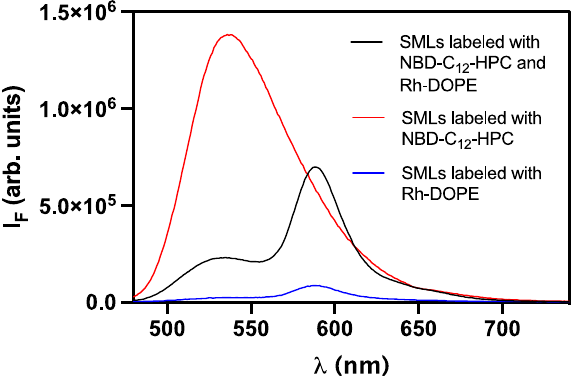
Figure 8. Fluorescence spectra ( λ exc = 470 nm) of SMLs with a DPPC bilayer labeled with only NBD-C 12 -HPC, with only Rh-DOPE and labeled with both NBD-C 12 -HPC and Rh-DOPE.